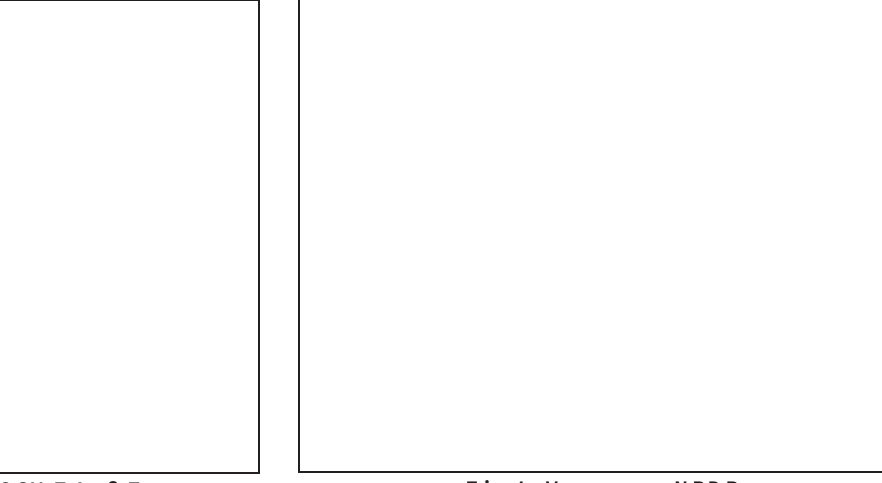
Fig. 1 : Mild NPDR with CSME Left Eye (Small arrow - Hg, Long arrow - CSME with hard exudate)